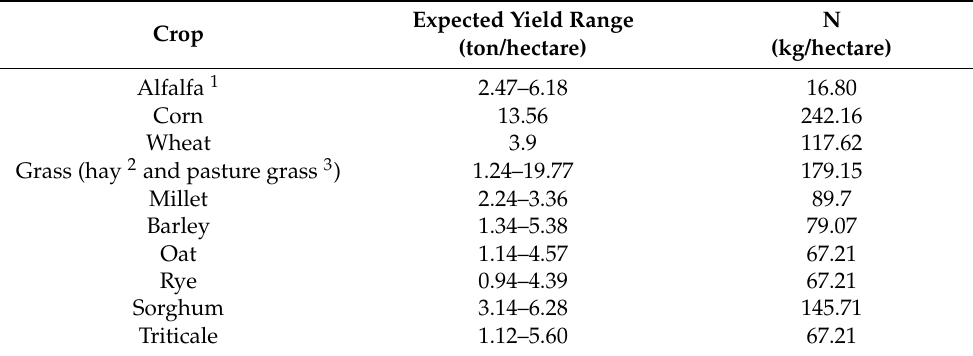
Table 2. Crop nitrogen